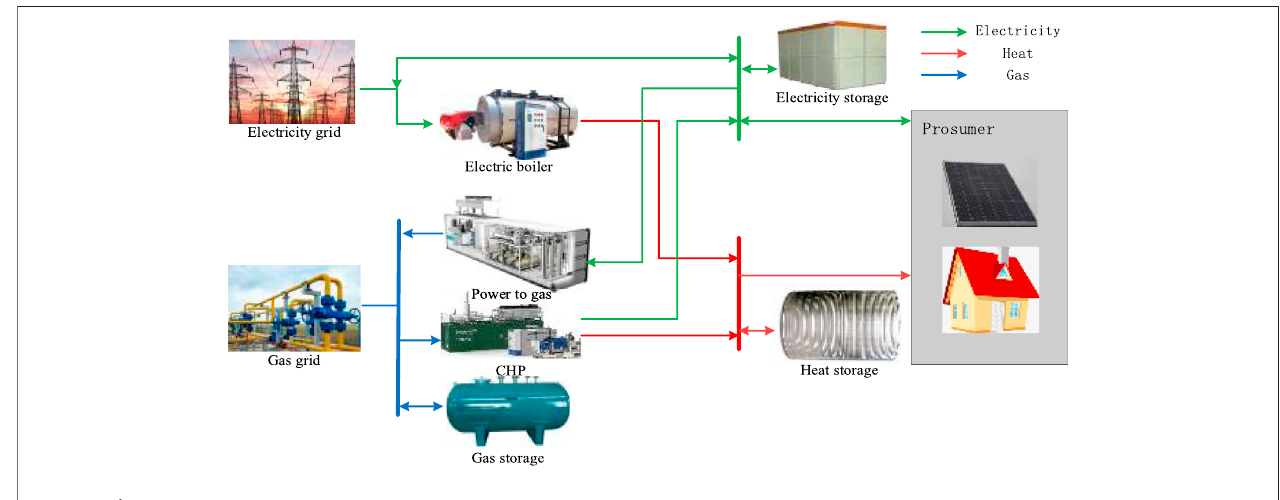
FIGURE 2 | structure of energy hub (EH) in